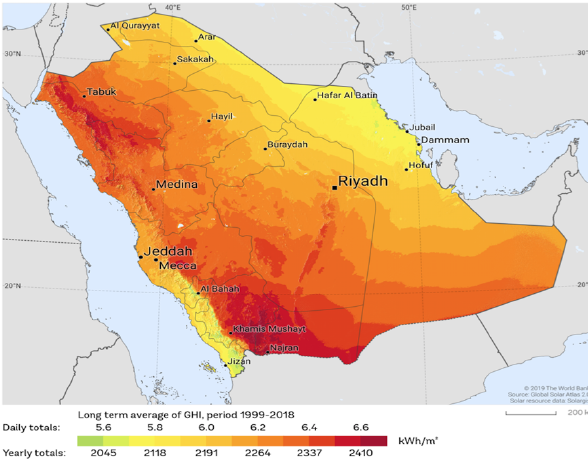
Figure 2: The average global horizontal solar radiance at KSA [6].